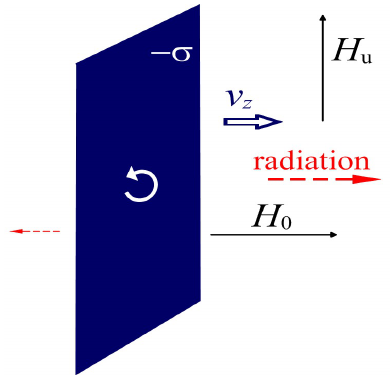
Figure 1. Perfect 1D source of Coherent Spontaneous Radiation (CSR) in the form of a moving plane formed by uniformly distributed electrons, which synchronously move along identical helical trajectories and emit plane waves in the positive and negative directions of the z axis .